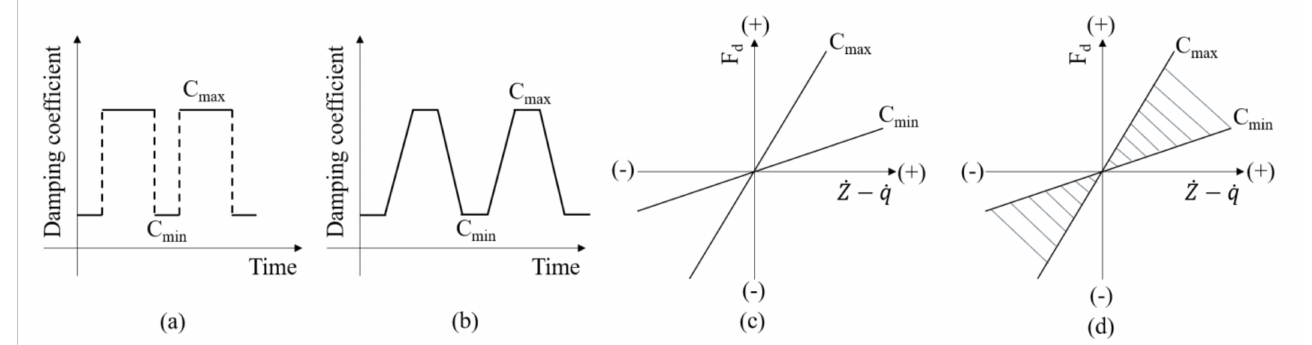
Figure 4. Damping coefficient control of ( a ) the on–off type ( b ), the continuous variable type and controllable force region, ( c ) the on–off type and ( d ) the continuous variable